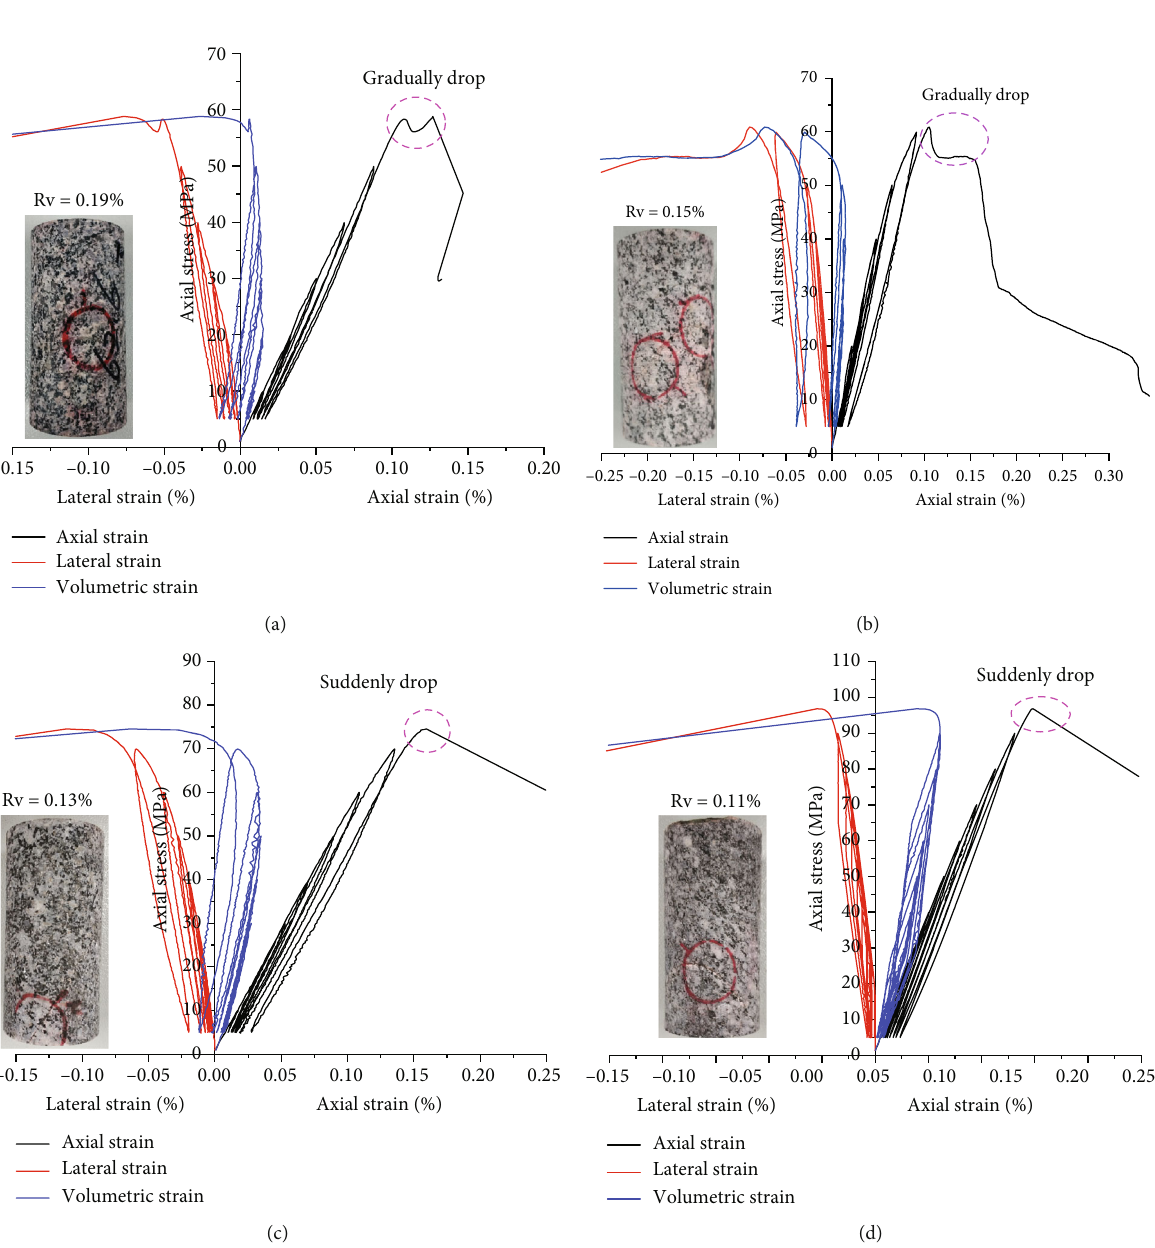
Figure 9: Axial stress strain curves for the samples experiencing di ff erent F-T cycles. (a – d) The natural fracture volume is 0.19%, 0.15%, 0.13%, and 0.11%,